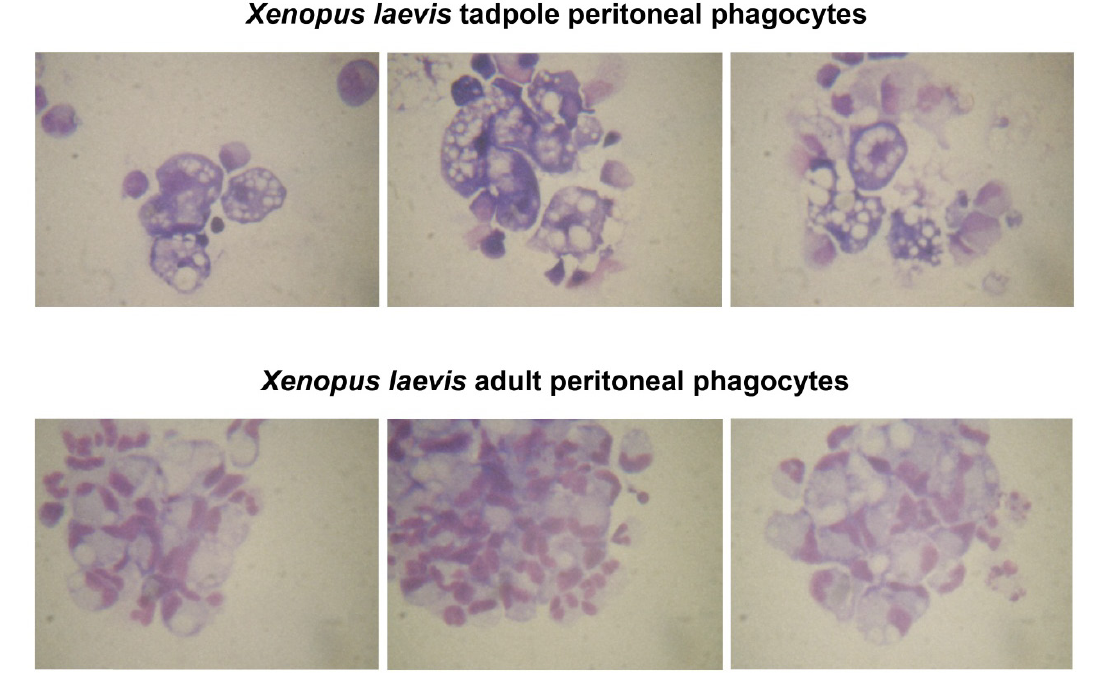
Figure 2. Comparison of Xenopus laevis tadpole and adult peritoneal macrophages. Peritoneal leukocytes were collected from frogs 3 days after elicitation with heat-killed Escherichia coli . Cells were seeded in and allowed to adhere to bottoms of 24 well plates for 3 hours. Non-adherent cells were removed, the adherent cells washed and cultured for further 4 days. Cells were cytospun onto glass slides and Giemsa stained according to standard protocol. Upper panels represent peritoneal macrophages collected from tadpoles and lower panels represent peritoneal macrophages derived from adult